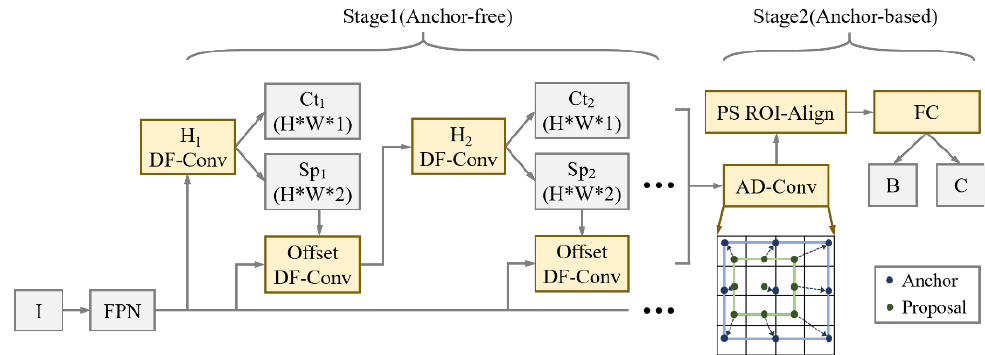
Figure 6. Cascaded Guided-Region Proposal Network (CG-RPN) with semantics-guided refinement.